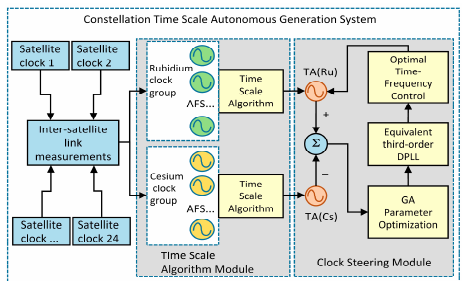
Figure 1. Comprehensive time scale generation system architecture diagram.